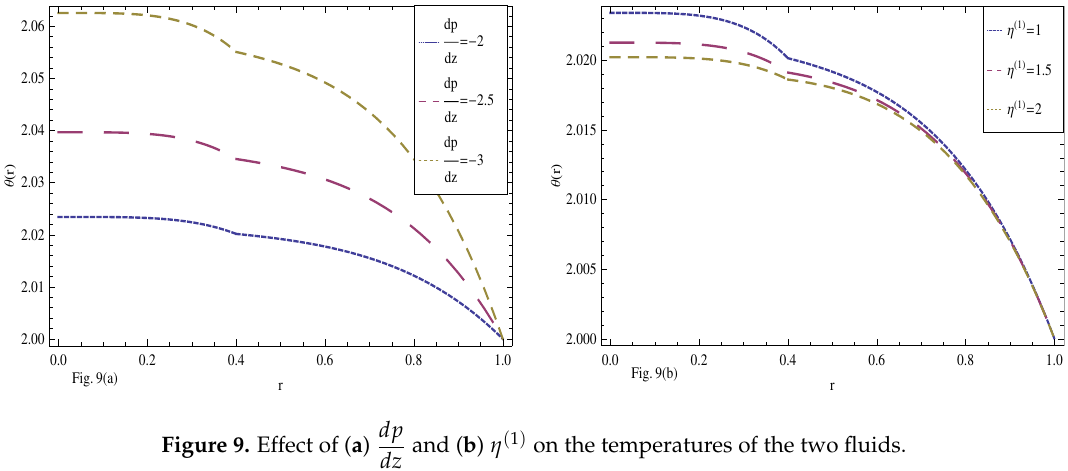
dp and ( b ) η ( 1 ) on the temperatures of the two dz